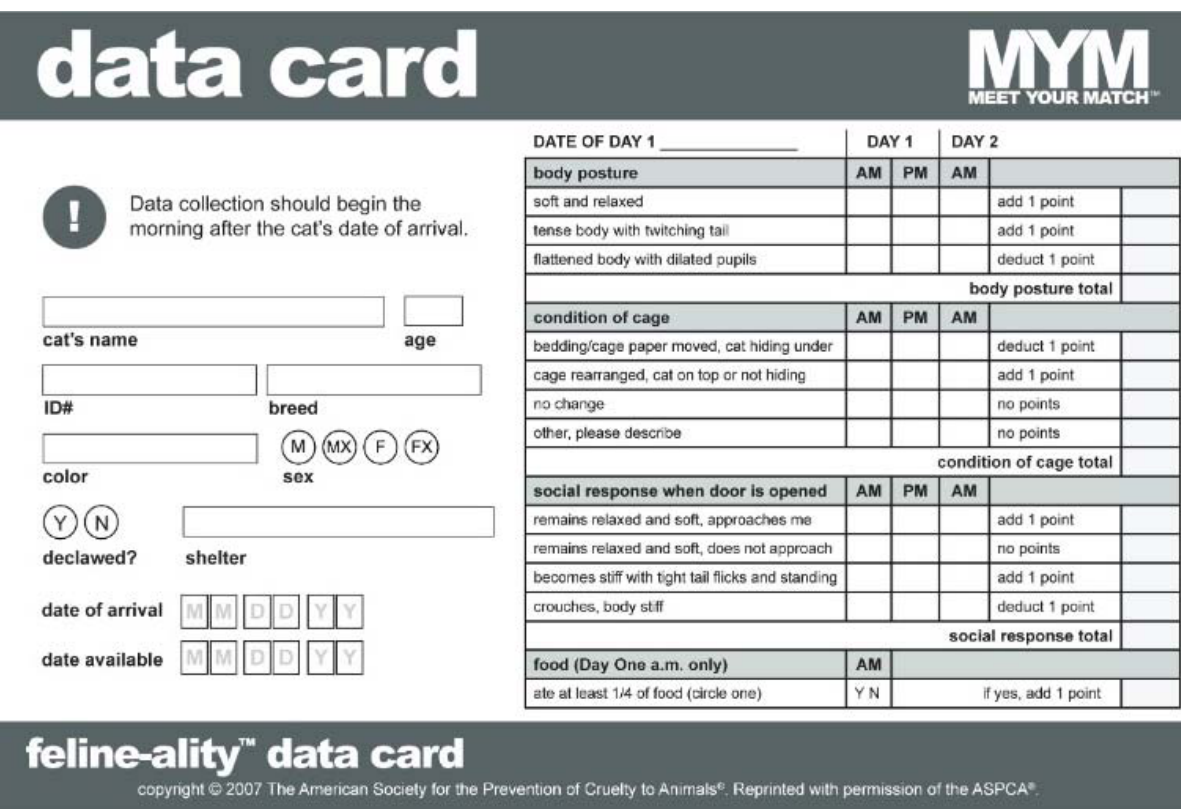
Figure 1. Original ASPCA ® Meet Your Match ® Feline-ality™ program data card from the Original Assessment Group. Table 1. Original ASPCA ® Meet Your Match ® Feline-ality™ program assessment items and scale to which they contribute.